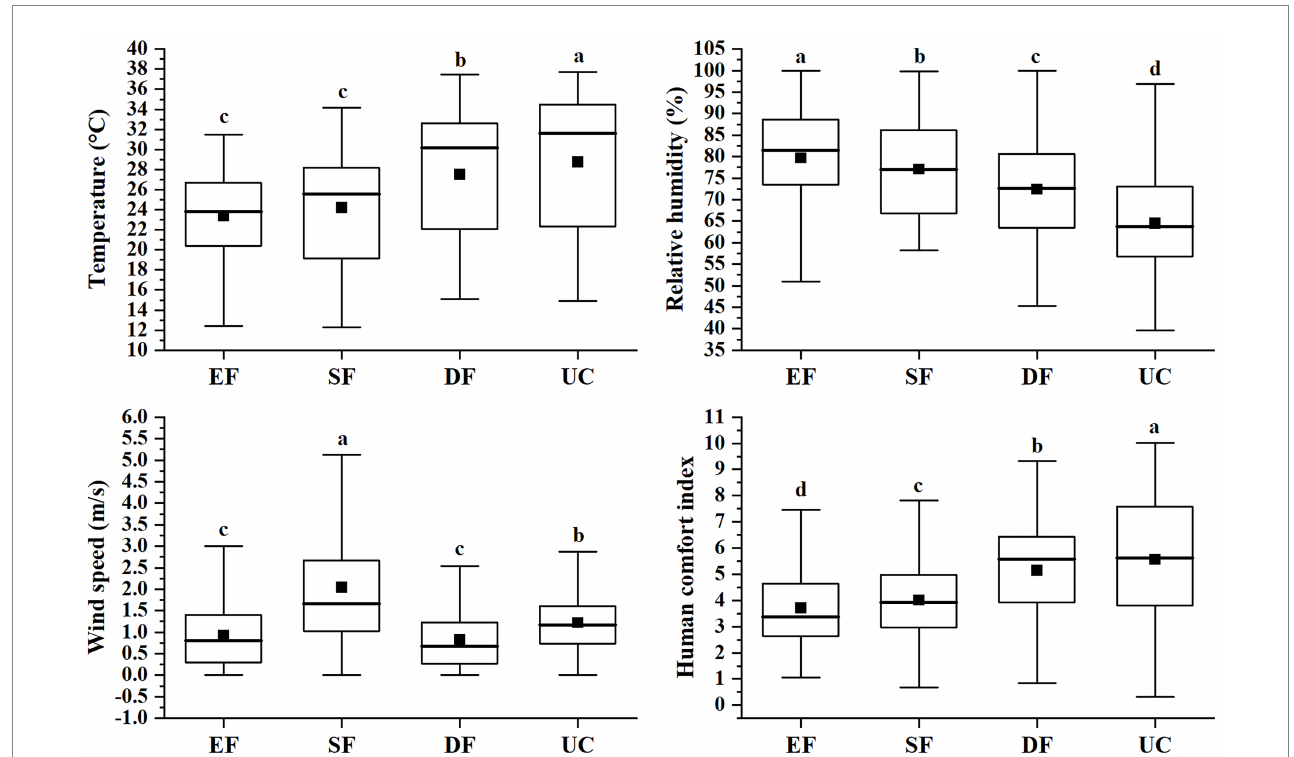
FIGURE 7 Comparison of annual average of forest microclimate and HCI of urban forests in different geographical